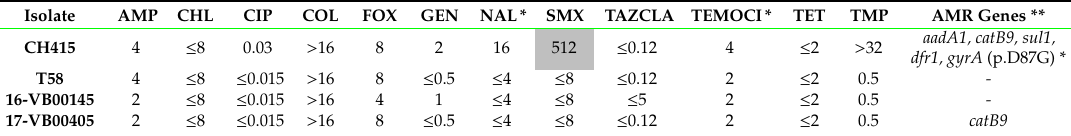
Phenotypic and genotypic results of antimicrobial resistance of V. cholerae non-O1, non-O139